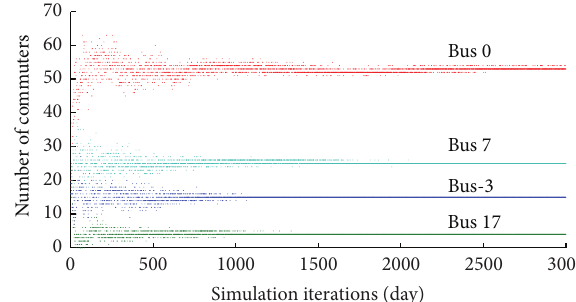
Figure 7: The change of commuters’ number on typical